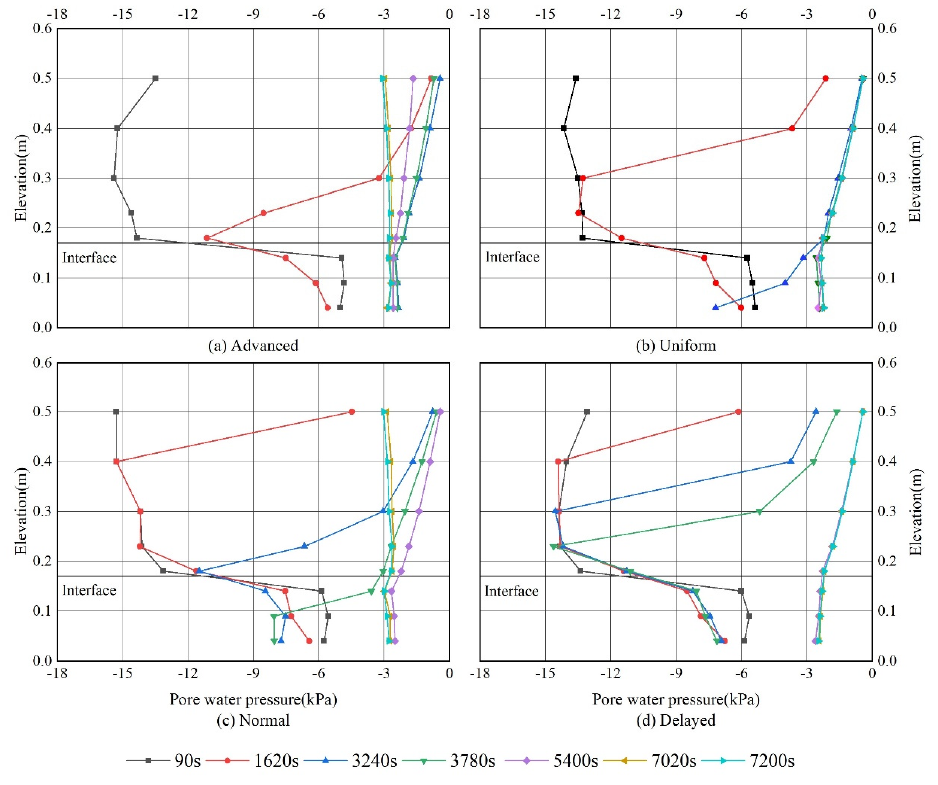
Figure 8. Pore water pressure profiles under relatively short rainfall duration. ( a ) Advanced, ( b ) Uniform, ( c ) Normal and ( d ) Delayed.